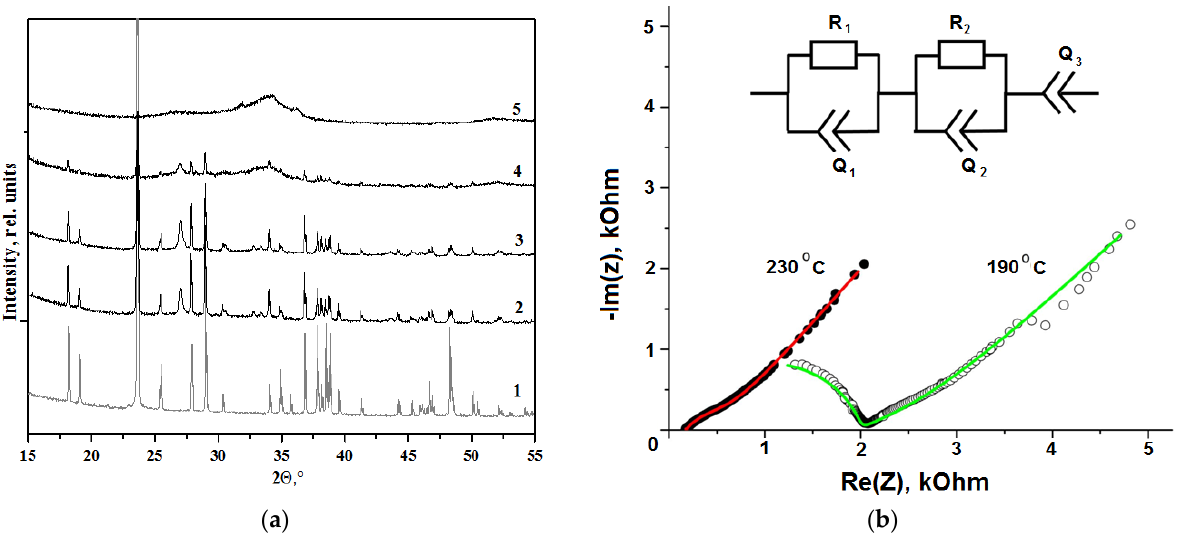
Figure 6. ( a ) X-ray diffraction patterns of (1– x )CsH 2 PO 4 – x ZnSnO 3 composites of various composi- tions in the comparison with the starting compounds: CsH 2 PO 4 (1); x = 0.2 (2); 0.4 (3); 0.8 (4); ZnSnO 3 (5). ( b ) Electrochemical impedance spectra for 0.8CsH 2 PO 4 –0.2ZnSnO 3 sample obtained at 230 °C (black symbols) and 190 °C (empty symbols). Points are experimental data; lines are theoretical curves obtained for the equivalent circuit, with the parameters listed in Table 2. The parameters of the equivalent scheme are described in detail the texts and Equations (5) − (7).